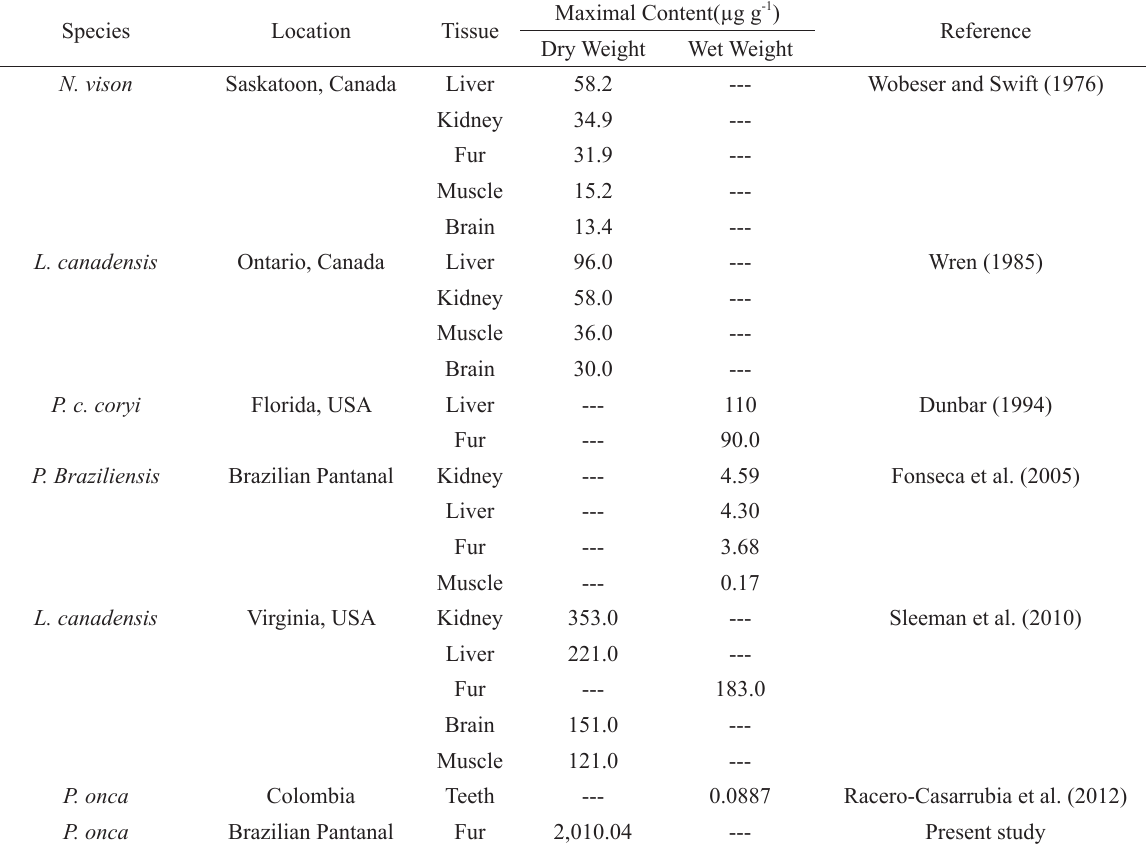
Maximum Hg level (µg g -1 dry weight) detected in the fur of jaguars ( Panthera onca ) from the Brazilian Pantanal in comparison to Hg contents (µg g -1 dry or wet weight) reported in previously published mammalian